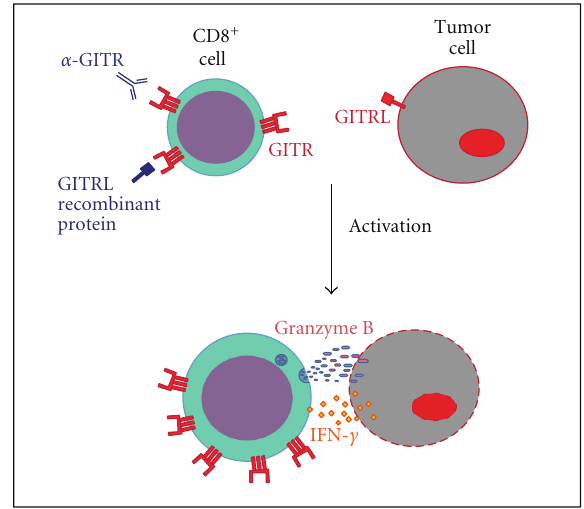
Figure 2: GITR function in antitumoral immunity. Treatment with anti-GITR antibody and GITRL recombinant protein induces activation of CD8 + cells through upregulation of GITR, release of IFN- γ and Granzyme B. There is evidence that some tumors express